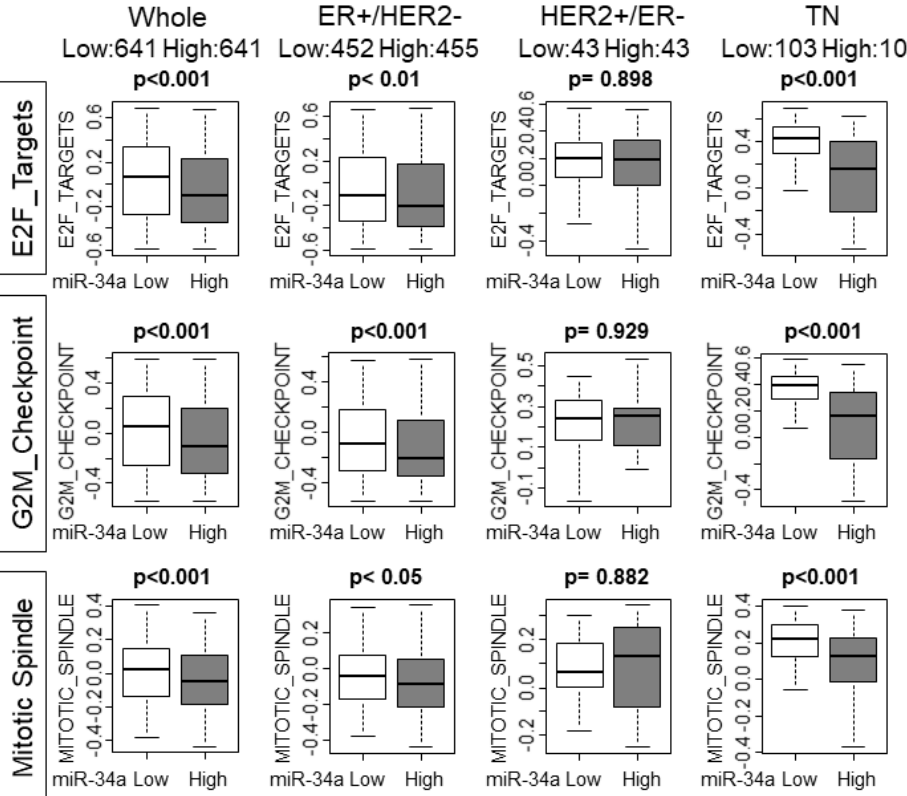
Figure 2. High MiR-34a breast cancer associate with lower gene sets variation analysis (GSVA) scores of the gene sets related to cell cycle or cell proliferation in whole METABRIC cohort and each subtype. Upper row: E2F_Targets, middle row: G2M_Checkpoint, lower row: Mitotic_Spindle Hallmark gene sets. GSVA, Gene Set Variant Analysis.